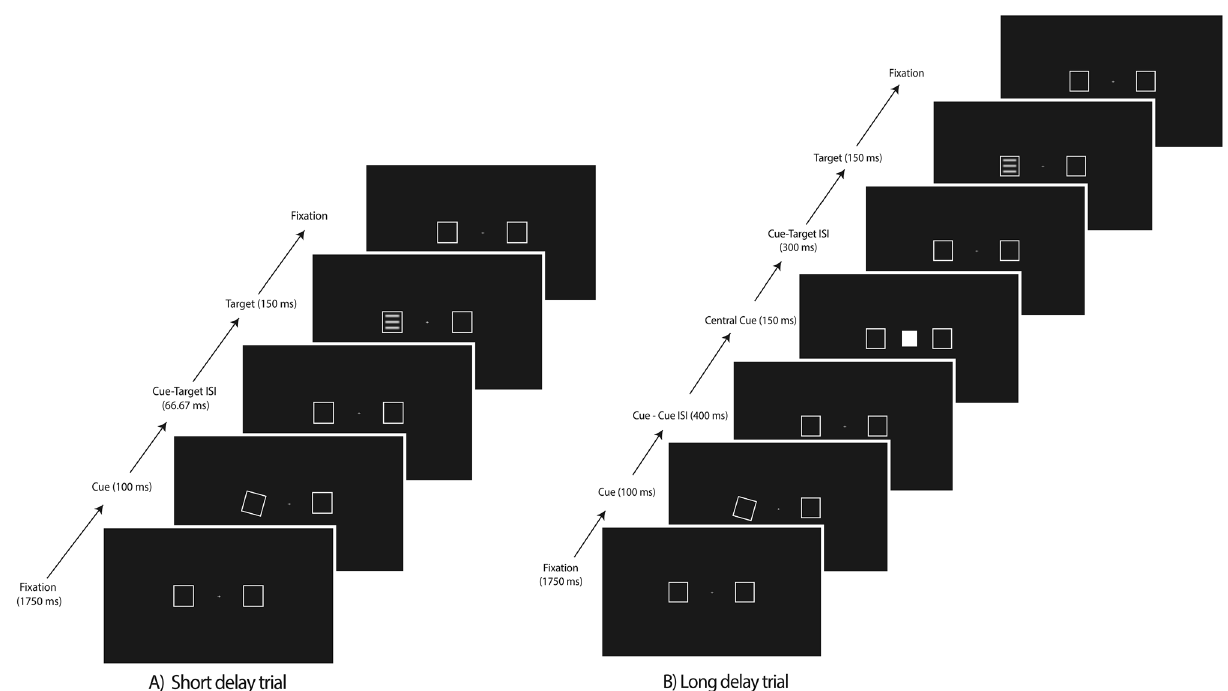
Figure 2. Sequence and timing of stimulus events in the attentional cuing task (kinetic cue) in Study. Trial- sequence for the ( A ) validly-cued at the left location for the short cue-target delay, and the ( B ) validly-cued at the left location for the long cue-target delay is shown. ISI = interstimulus interval. Participants were able to input their response at the final fixation panel. Max response time allowed = 1000